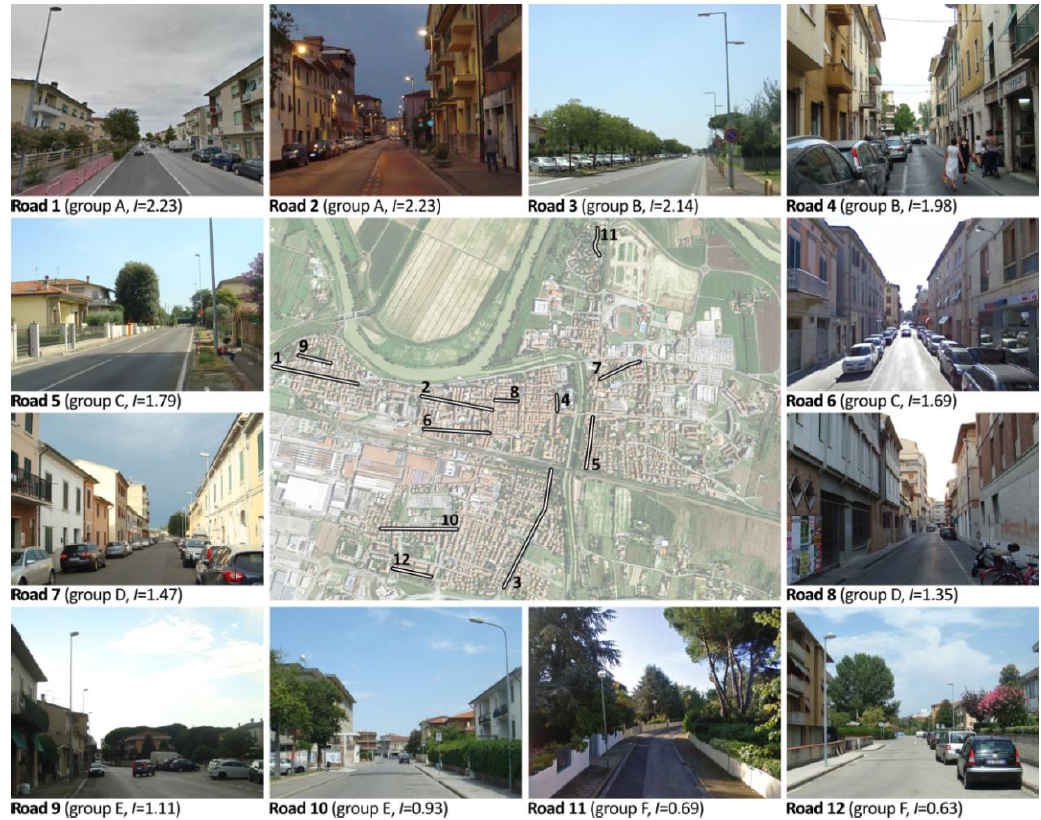
Figure 8. Pontedera roads involved in software simulation; for each road the ID number, the road group (see Table 1) and the integration index value, I , are indicated. Table 4. Lighting classes and minimum lighting requirements for the 12 selected